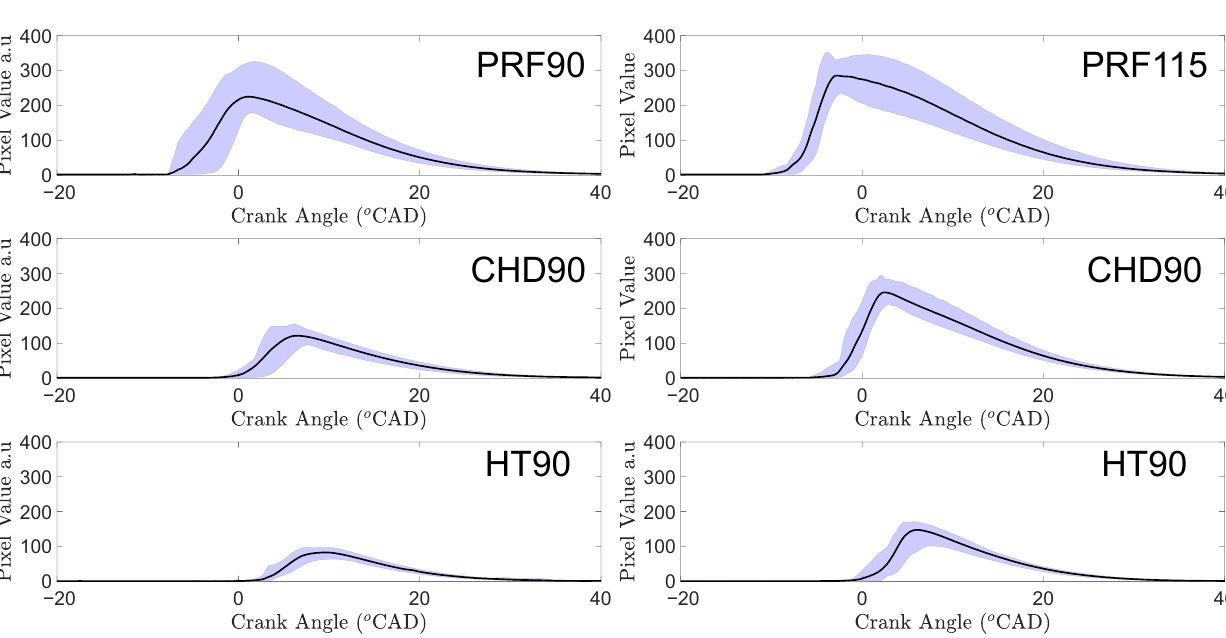
Figure 12. Average pixel intensity (arbitrary units a.u) collected by high speed camera against CAD. Solid black line is the mean value from 8 combustion events, the blue region around the line indicates the